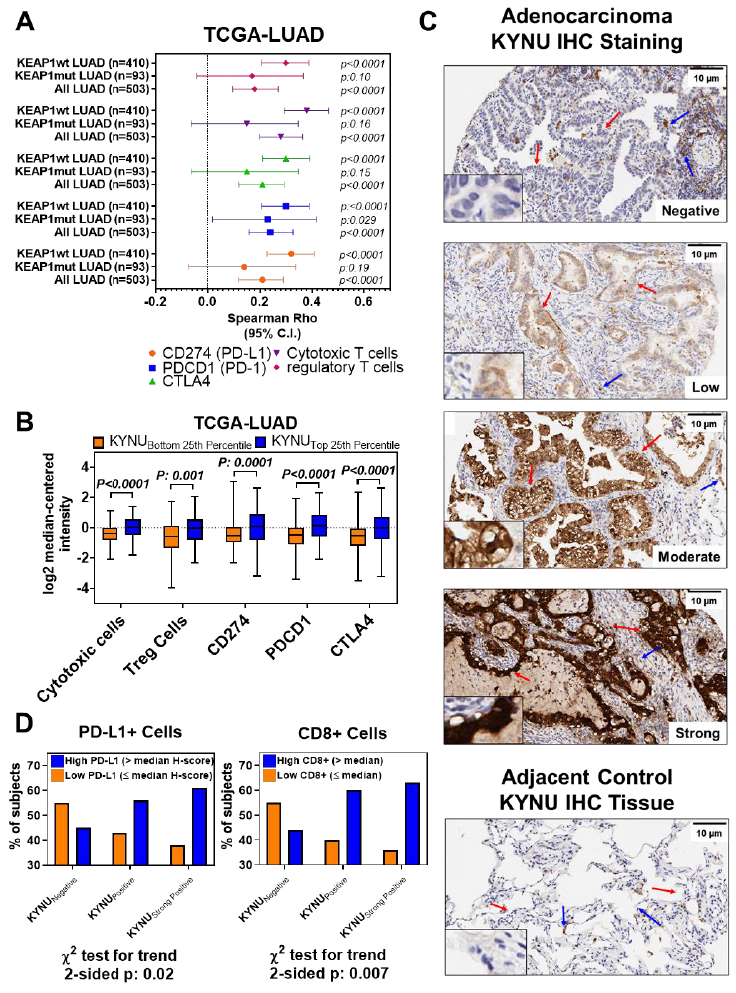
Figure 3. Association between KYNU and tumor immunophenotype. ( A ) Scatter plot illustrating Spearman correlations (95% CI) between continuous values of KYNU mRNA expression with gene-based signatures of cytotoxic T-cells, regulatory T cells, and immune checkpoint blockaded related genes CD274 (PD-L1), PDCD1 (PD1), and CTLA4 in TCGA-LUAD tumors stratified by presence or absence of KEAP1 mutations. ( B ) Distribution of gene-based signatures reflective of cytotoxic T-cells, regulatory T cells, and immune checkpoint blockade-related genes CD274 (PD-L1), PDCD1 (PD1), and CTLA4 in TCGA-LUAD tumors stratified by KYNU mRNA expression into the bottom and top 25th percentiles. Statistical significance was determined by a two-sided Wilcoxon rank sum test. ( C ) Representative immunohistochemistry (IHC) staining of KYNU protein expression in adenocarcinoma TMA stratified by KYNU protein expression (negative, positive (50–150) and strong positivity (>150)), as well as adjacent control tissue. Red arrows indicate tumor tissue while blue arrows indicate inflammatory cell staining. Insets show a 5 × enlargement. ( D ) Association between KYNU protein expression (negative, positive (50–150) and strong positivity (>150)) and PD-L1 staining positivity and CD8+ TILs (E) in LUAD TMAs. PD-L1 was stratified based on whether PD-L1 was >median of the H-Score (high) or ≤ median of H-scores (low). CD8+ levels were stratified into either high (>median of positive cells per millimeter (mm) 2 tissue) or low ( ≤ median of positive cells per mm 2 tissue). Statistical significance was determined by two-sided χ 2 test for